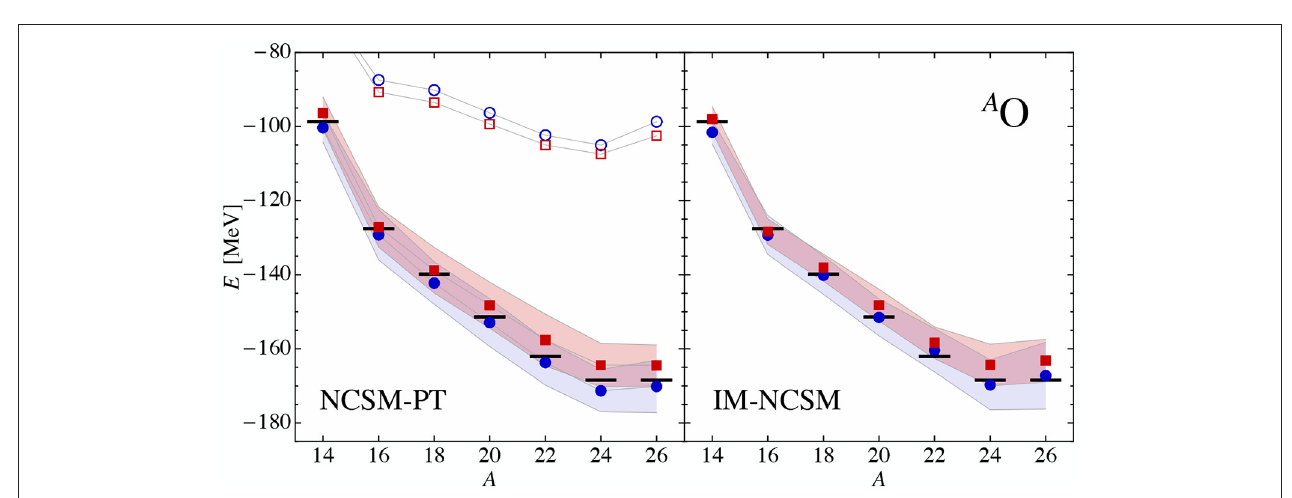
FIGURE 13 | Even oxygen isotopes ground-state energies from reference (empty symbols) and second-order (full symbols) NCSM-PT with N ref max = 2 (left) and from IM-NCSM (right) . The consistent non-local 2N plus 3N chiral interactions at N 2 LO ( l ) and N 3 LO ( (cid:4) ) presented in Hüther et al. [115] are employed with a cutoff 3 = 500 MeV. The uncertainty bands represent both many-body and interaction uncertainties (see text). Both many-body calculations make use a natural-orbital basis obtained in 13 oscillator shells with ¯ h ω =